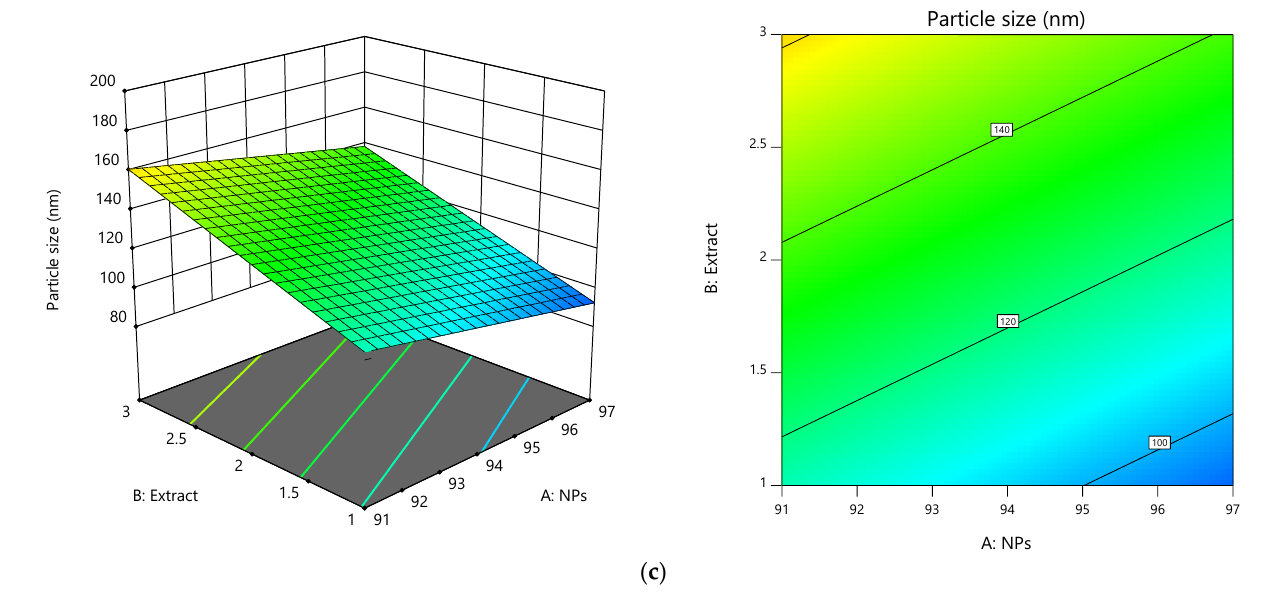
Figure 2. (left) 3D response surface and (right) contour plot of model conditions of silver-nanoparticle-complexed G. applanatum : silver nanoparticles ( X 1 ), G. applanatum extract ( X 2 ), and ionic liquid ( X 3 ) as independent variables, and particle size as a dependent variable. ( a ) X 3 = 2, ( b ) X 3 = 4, and ( c ) X 3 = 6.